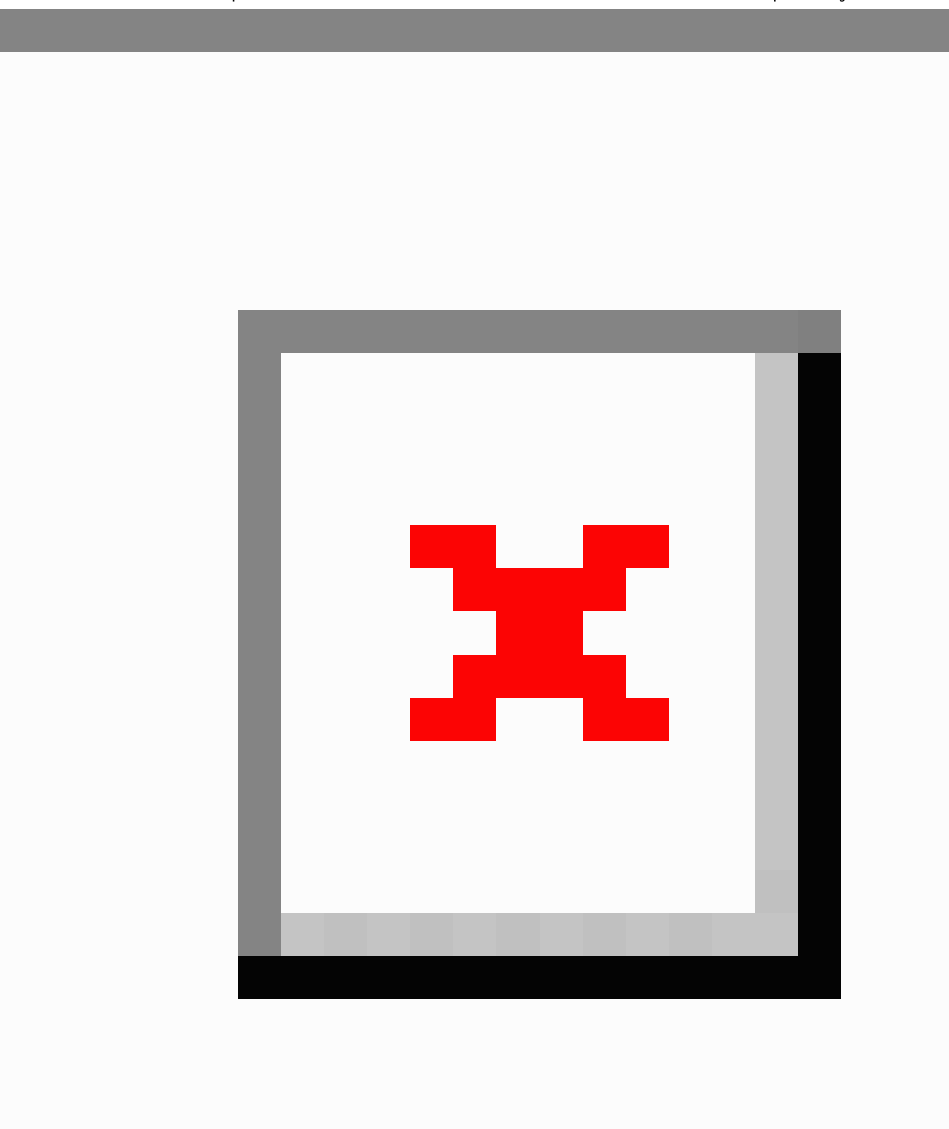
Figure 1. Combining audiovisual information with conversational narration style results in highest recall of eHealth information among younger and older adults. The bars and error bars represent the mean recall scores and 95% confidence intervals